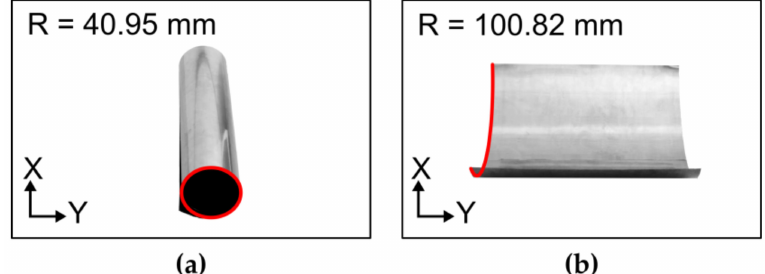
Figure 3. Bistable tube (produced by incremental die-bending with R 1 = R 2 = 6 mm) in deployed state as the first stable state ( a ) and (partially) folded configuration as the second stable state ( b )